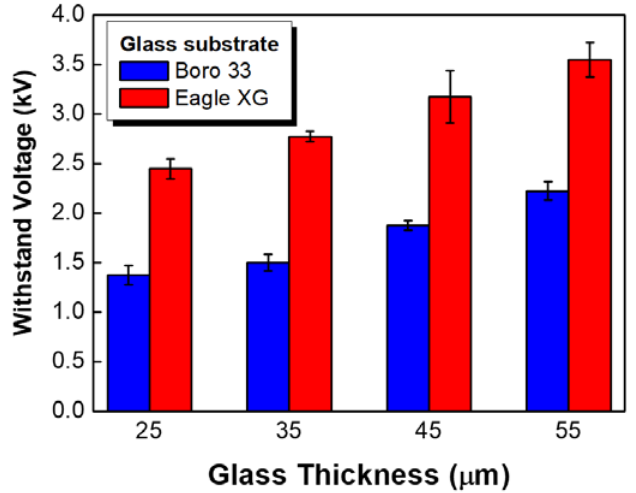
Figure 6. Withstand voltages of Si strain gauges with four different glass thicknesses; gauges were fabricated on two different glass substrates represented by red and blue (number of samples = 50).